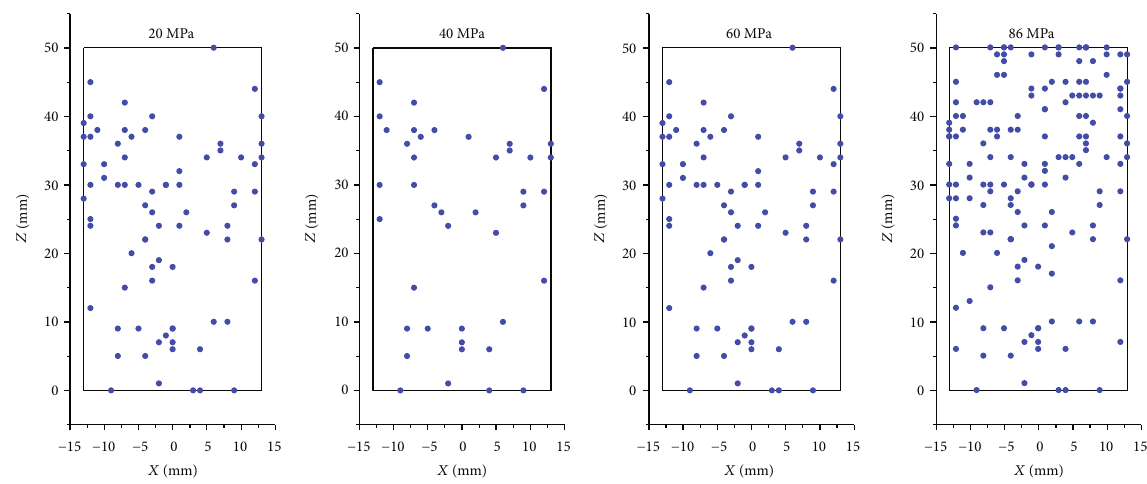
Figure 14: The projections of AE locations under di ff erent stresses of shale